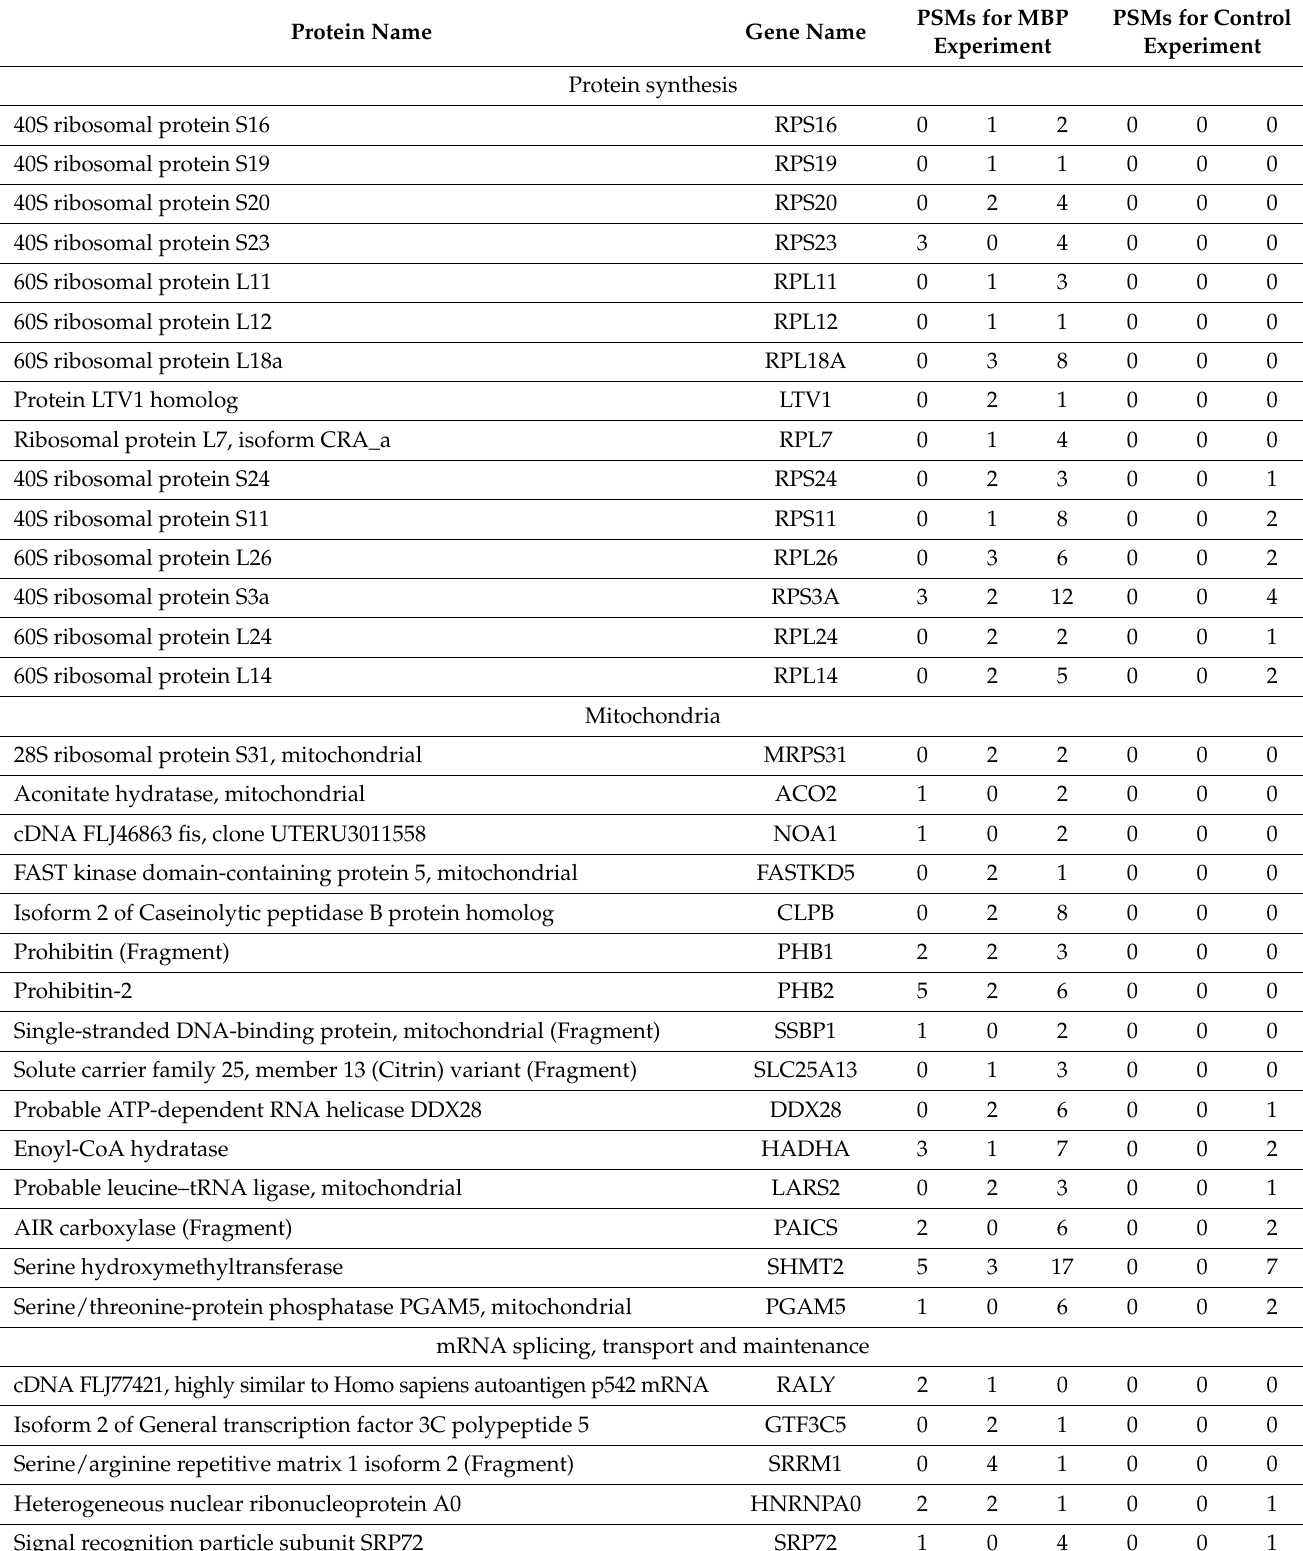
Table 1. List of potential MBP interacting proteins. PSMs—Peptide-Spectrum